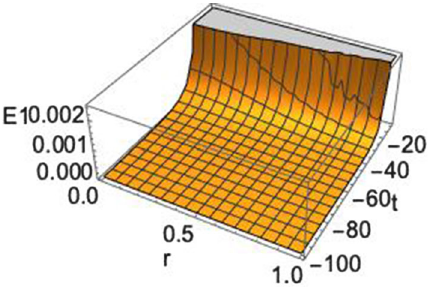
Fig. 5 E 1 = (ρ + p ) 2 − 4 Q 2 > 0 as a function of the radial and temporal coordinates